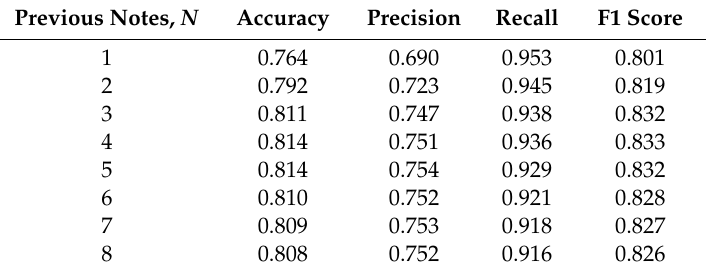
Table 2. Performance of automated identification of new information using manual annotation as the reference standard by increasing the number of previous notes.